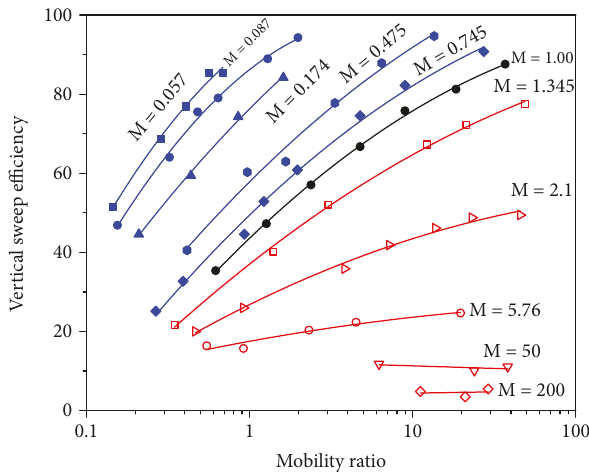
Figure 3: Vertical sweep e ffi ciency a ff ected by the mobility ratio